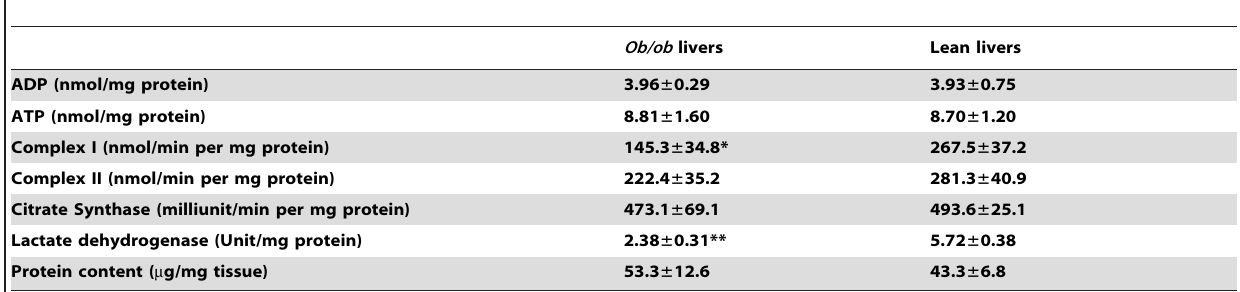
Table 1. Baseline measurement of ADP and ATP contents; Complex I, Complex II, Citrate Synthase and lactate dehydrogenase levels in ob/ob and lean